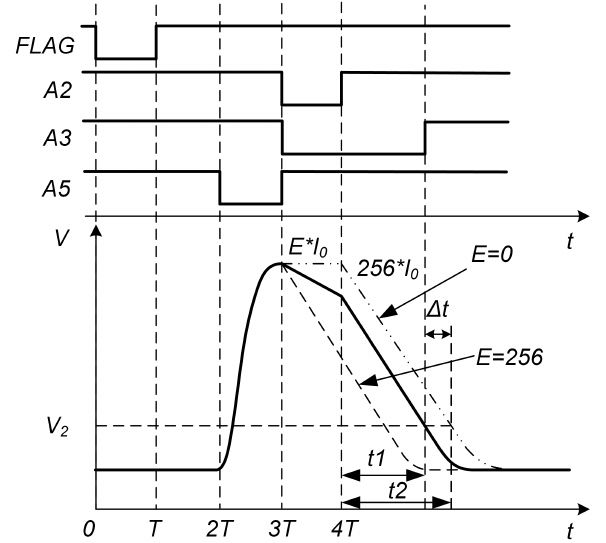
Figure 7. Waveform of the signals in proposed DTC.